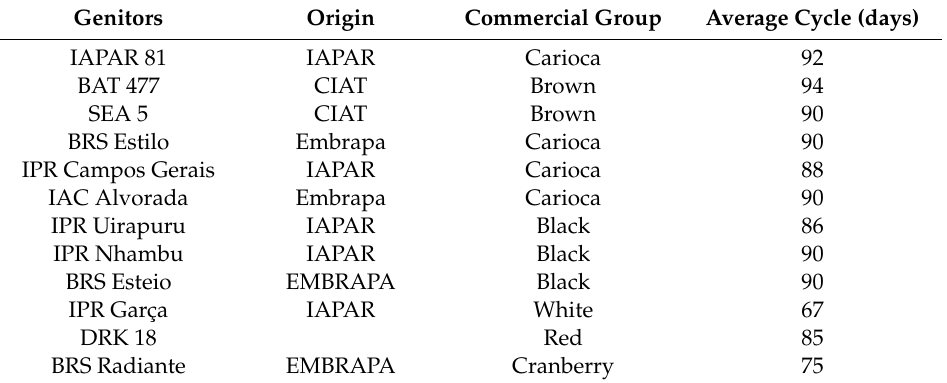
BRS Radiante EMBRAPA